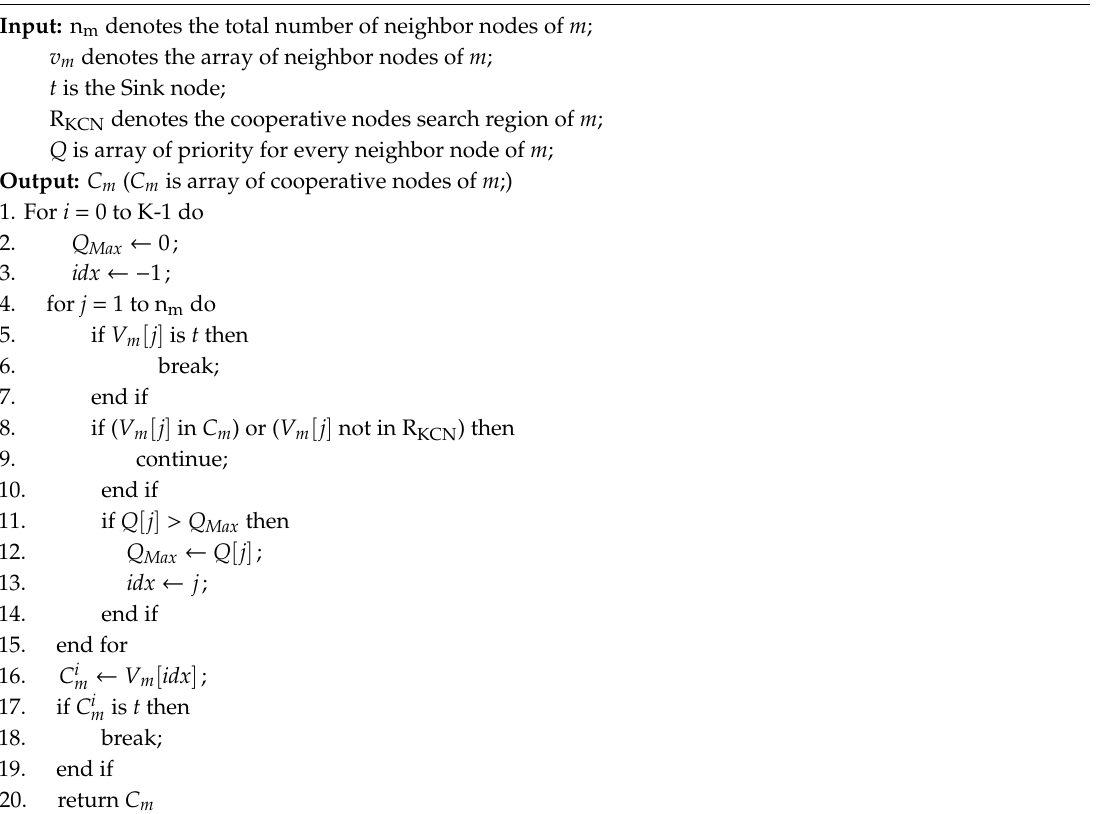
Algorithm 1. Choose CN (n m , v m , t ,R KCN , Q ).